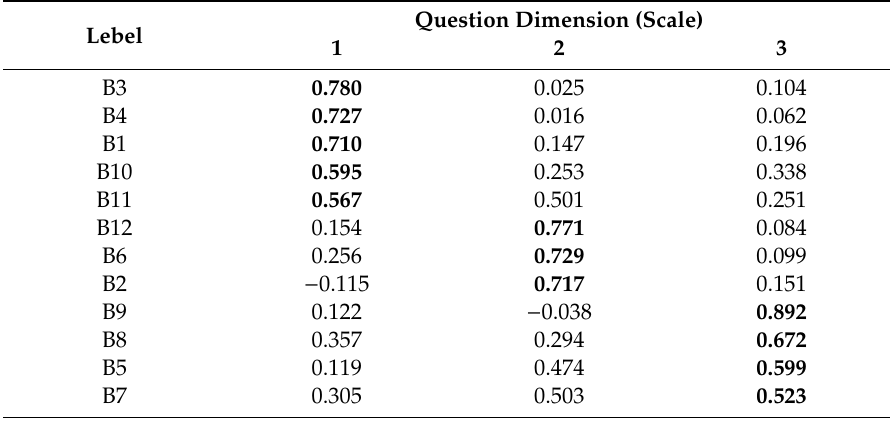
Table A3. Rotated component